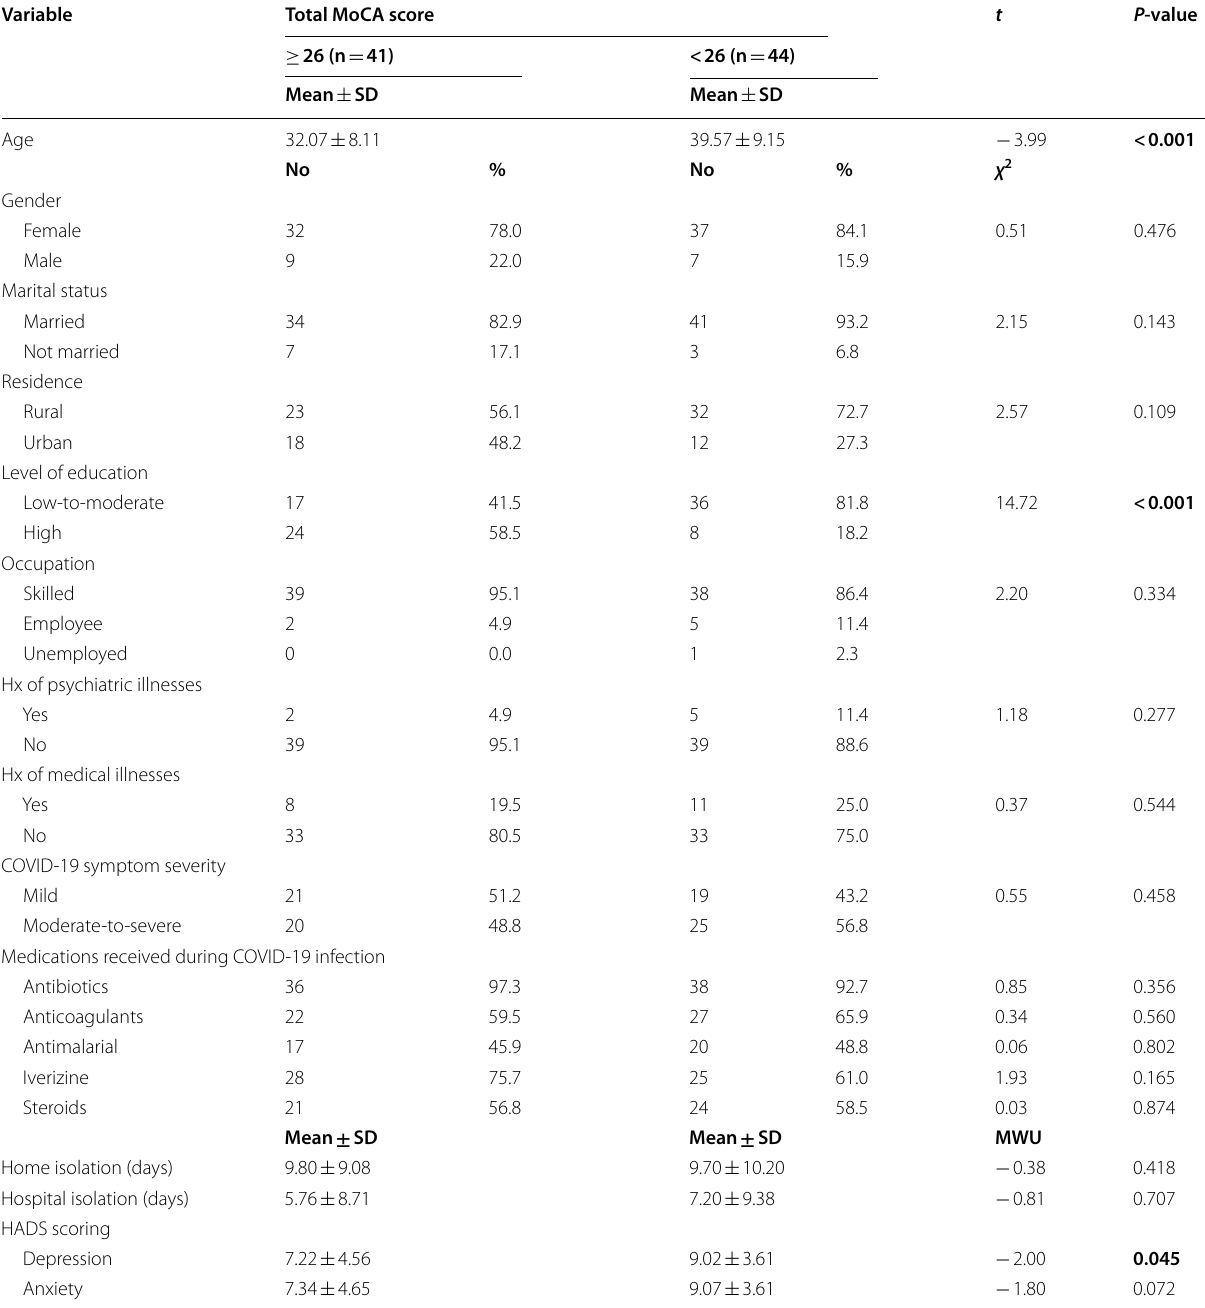
Bold text indicates statistical significance, where P value <